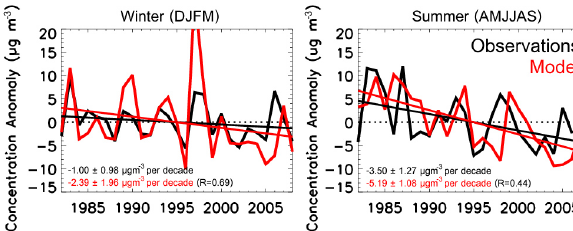
Figure 4. Seasonally averaged surface concentrations anomalies from Barbados observations (black) and from the model (red) are shown for winter and summer. Trend lines are plotted as solid lines and the slope with one standard deviation indicated for each sea- son. The correlation ( R ) between the observations and model data is shown on each panel.